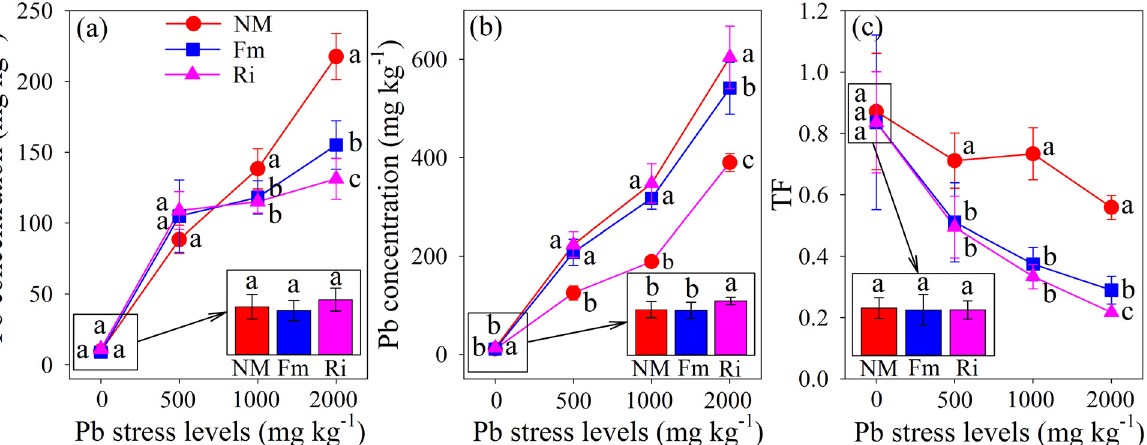
Fig 2. Pb concentrations in leaves (a) and roots (b), and the TF (c) of R . pseudoacacia were affected by Pb stress levels and AMF inoculation. NM, non-inoculated control; Fm, inoculated with F . mosseae ; and Ri, inoculated with R . intraradices . The results are the mean (n = 6) ± SD. The same letter indicates no significant difference among treatments (Duncan ’ s test, P < 0.05). Two-way ANOVAs were used to determine the significance of the effects of Pb stress (Pb), AMF inoculation (AMF), and their interactions (Pb × AMF) on the Pb concentration and TF of black locust seedlings, as shown in S1 Table.